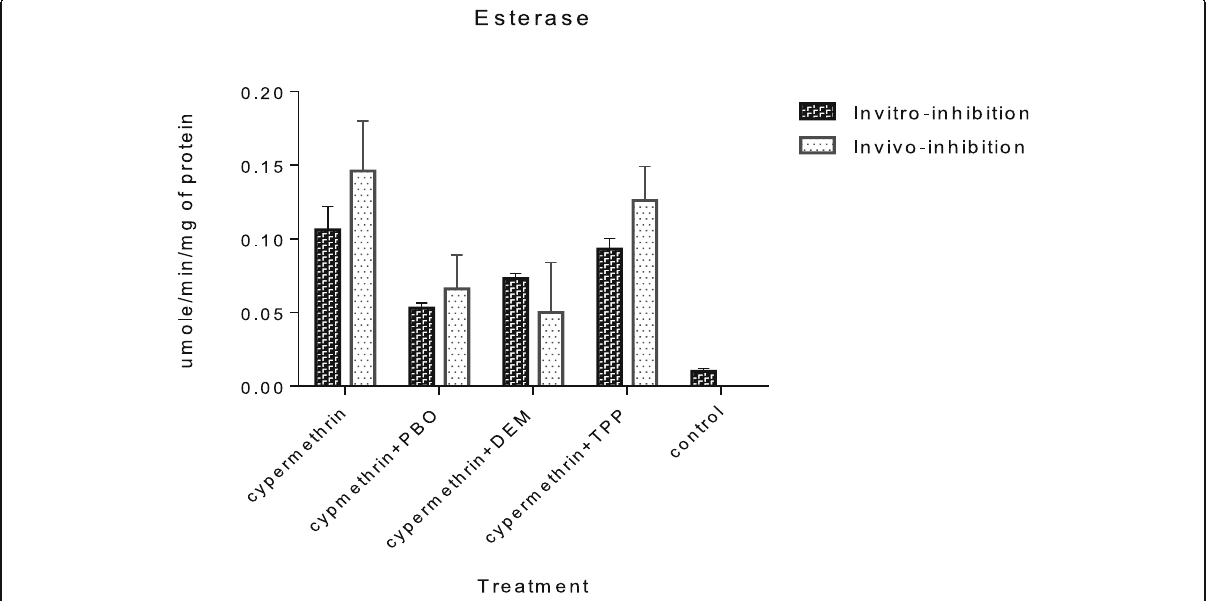
Fig. 2 In vitro and in vivo inhibition of fourth instar larvae Amsacta albistriga esterase activity with and without enzyme inhibitor (PBO, DEM, and